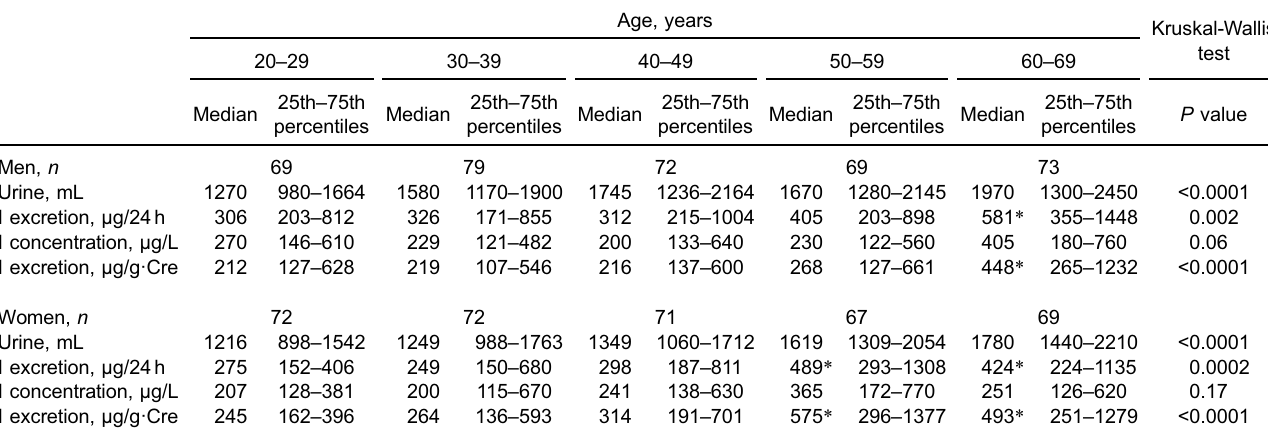
Table 3. Iodine excretion in 24-hour urine and iodine concentration (µg/L and µg/g·Cre) by age and sex in 713 Japanese